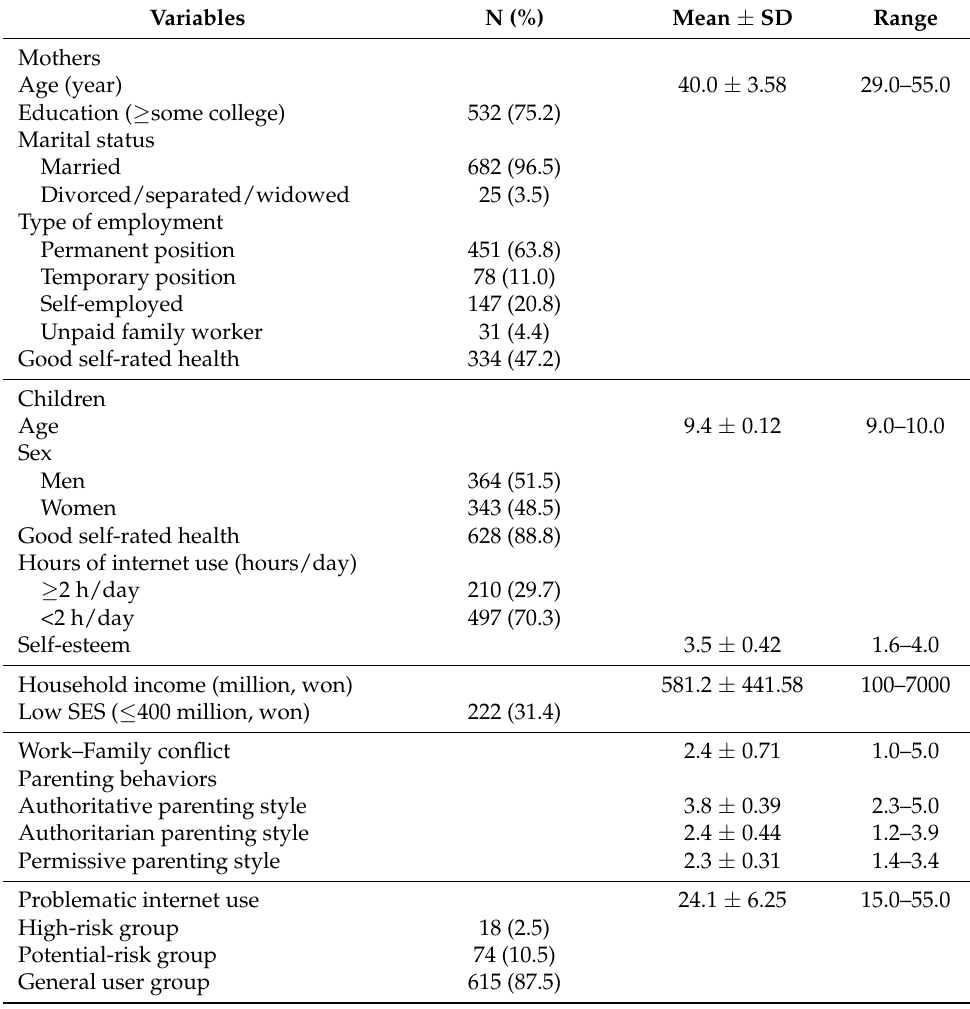
Table 1. Participant’s general characteristics (N =